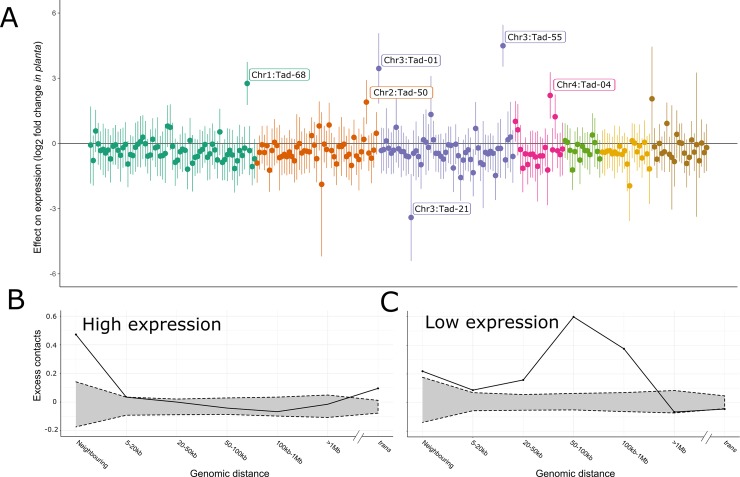
The three-dimensional structure of the genome is associated with regulation of gene expression.A: Each point represents data from all genes within a single TAD; the estimated log2 fold difference in expression between in planta and in culture conditions for these genes within that TAD are plotted (i.e., points above zero represent TADs for which genes are generally more highly expressed in planta). Vertical lines represent uncorrected 95% confidence intervals of this estimate; TADs are coloured by chromosome. TADs with statistically significant effects after applying a false discovery rate of 0.01 are labelled by chromosome and TAD number. Genes contained in these TADs are listed in S5 Table. B: The proportional excess ([observed - expected]/observed) of contacts between members of the 5% of genes with the highest expression in culture. Along the x-axis, these interactions are broken down by the genomic distance between interacting gene pairs. 95% confidence intervals for expected number of contacts (grey shaded area) for each observation were obtained by counting the number of contacts from 1,000 random gene sets. Points falling outside the shaded space represent genomic distances at which highly-expressed genes contact each other more than would be expected by chance. C: As with B, but for the 5% of genes with the lowest expression in culture.